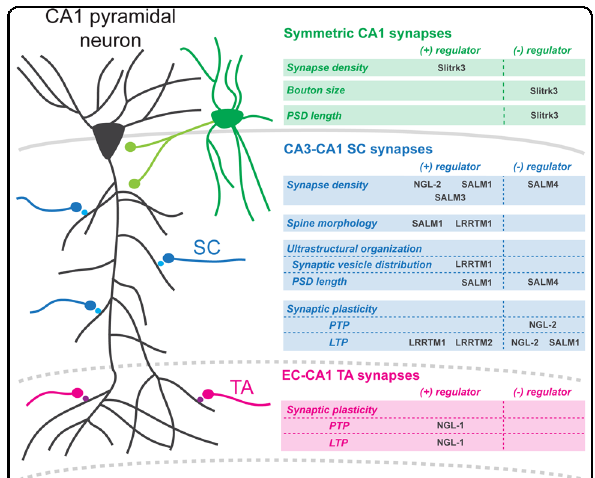
Fig. 1 LRR proteins regulate synapse development in CA1 pyramidal neurons. Symmetric CA1 synapses. Slitrk3 regulates density, pre-synaptic bouton size, and ultrastructural organization of inhibitory synapses formed on CA1 pyramidal cell bodies and in CA1 stratum radiatum (SR), presumably by local GABAergic interneurons (green). CA3-CA1 SC synapses. Different LRR proteins regulate synapse density on the proximal apical dendritic segment, where Schaffer collateral (SC) axons synapse onto CA1 neurons (black). NGL-2, SALM1, and SALM3 positively regulate dendritic spine density, whereas SALM4 negatively regulates SC spine density. LRRTM1, SALM1, and SALM4 in fl uence synapse structure or ultrastructure. LRRTM1 loss results in longer, possibly less mature, spines, as well as a dispersion of vesicles in the pre-synaptic bouton. SALM1 loss results in odd-looking spines with thin protrusions emerging from the spine heads, as well as a decrease in post-synaptic density (PSD) length and an increase in the proportion of perforated synapses. SALM4 loss results in an increase in PSD length. LRRTM1/2, NGL-2, and SALM1 affect short- or long-term synaptic plasticity. Loss of LRRTM1/2 results in a long-term potentiation (LTP) block. Loss of SALM1 results in enhanced LTP. Loss of netrin-G2, the pre-synaptic binding partner of NGL-2, also results in enhanced LTP as well as facilitation of